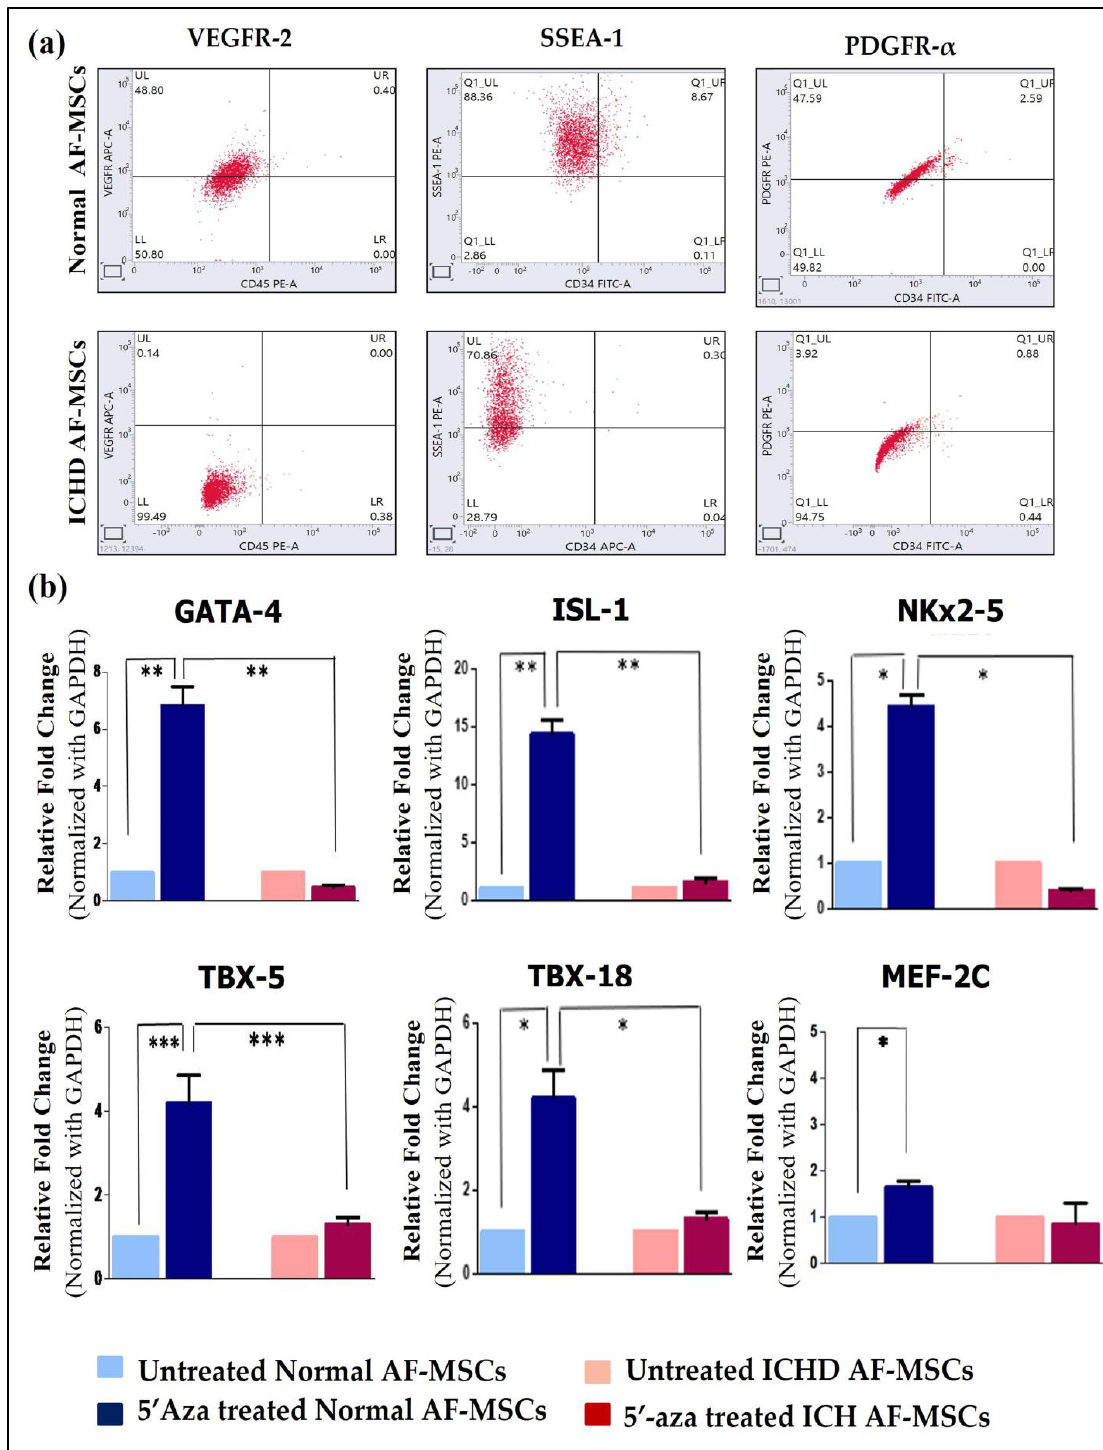
Figure 3. Expression of cardiac progenitor markers and cardiac transcription factors by normal AF-MSCs and ICHD AF-MSCs. ( a ) Representative flow cytometric dot plots of normal AF-MSCs and ICHD AF-MSCs expressing cardiac progenitor markers VEGFR-2, SSEA-1, and PDGFR- α (repetition = 03). ( b ) Real-time PCR showing expression of cardiac transcription factors viz. GATA-4, ISL-1, NKx 2-5, TBX-5, TBX-18, and MeF-2C in 5 (cid:48) -aza-treated normal AF-MSCs (dark blue bar) with 5 (cid:48) -aza-treated ICHD AF-MSCs (red bar). (1 × 10 6 cells for each untreated and 5 (cid:48) -aza-treated ICHD and normal AF-MSCs). Values are expressed as mean ± SD; * p < 0.05, ** p < 0.01, *** p <